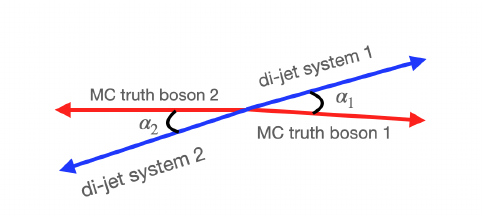
Figure 13 . The definition of α 1 and α 2 .